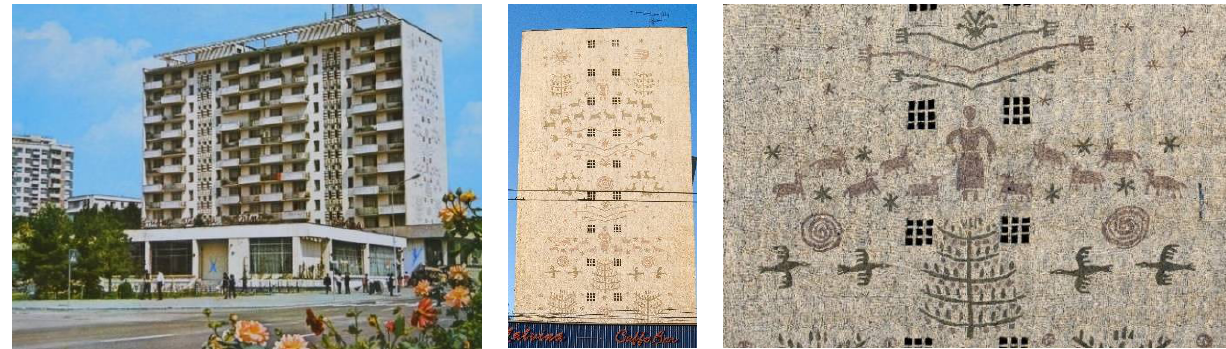
Figure 3. The “Mioriţa” mosaic on the Arini tower block. (Source: Circulated postcard and Petru Palamar).